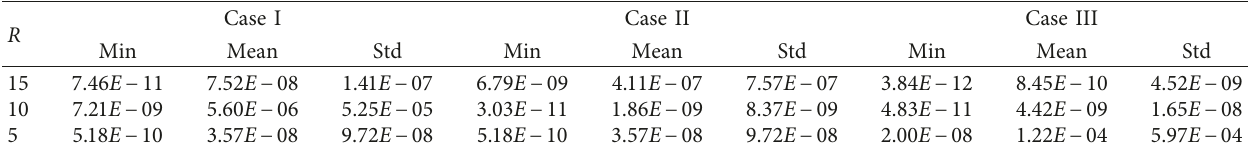
Table 8: Results of ENSE obtained by the design scheme during 20 independent